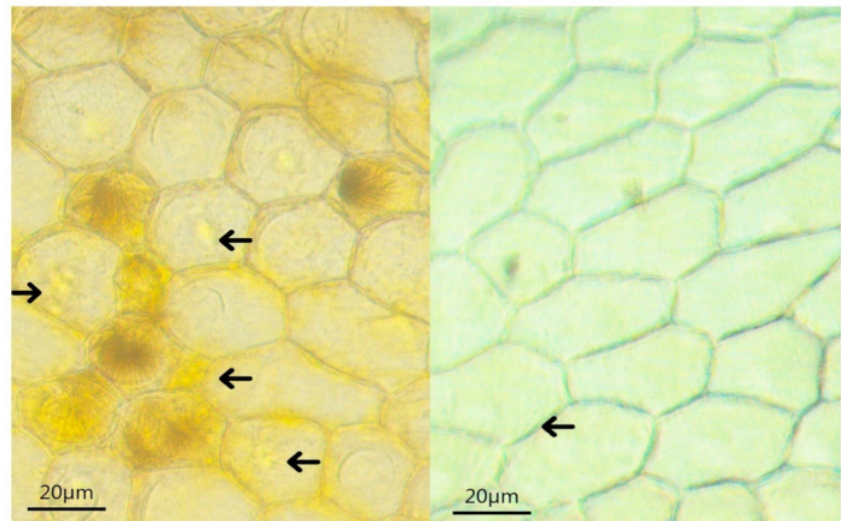
Figure 2. Chromoplasts contained in epidermal cells of ‘Jinzhan Yintai’ and yellow mutant tepals. The arrows in the left picture point to yellow chromoplasts, and the arrows in the right picture point to white chromoplasts. Bar = 20 µ m.